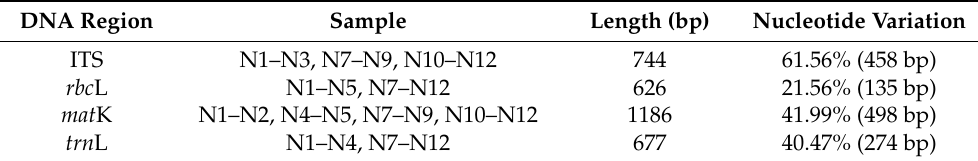
Table 4. Characteristics of the analyzed sequences.